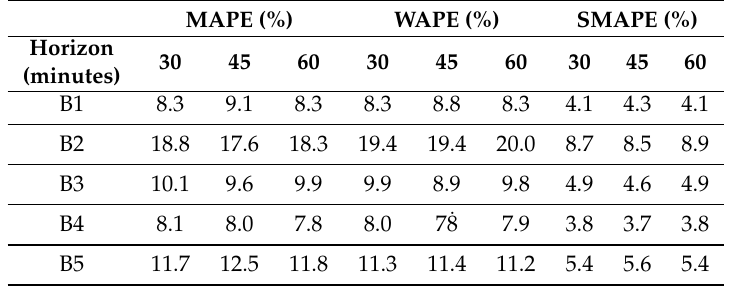
Table 8. Artificial neural network model prediction errors for different horizon lenghts: 30, 45, and 60 min; time frame: 6 a.m.–10